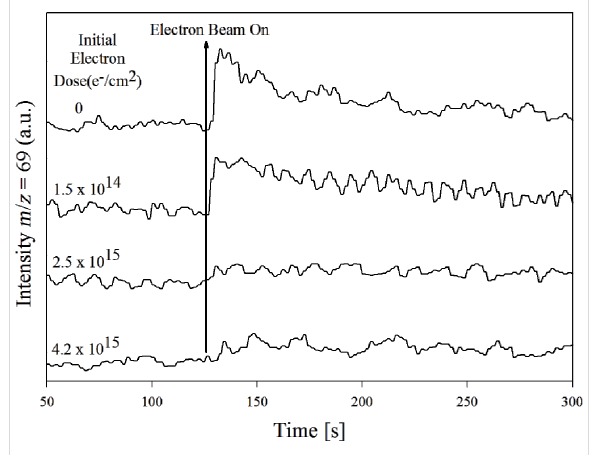
Figure 15: Time-resolved mass spectra of gas phase PF 3 (positive [PF 2 ] + ions produced by 70 eV electron impact are recorded) desorbing from films of Pt(PF 3 ) 4 adsorbed on an Au surface at 180 K when these are irradiated with 500 eV electrons. The time at which the electron beam is turned on is represented with a vertical line. Repro- duced with permission from [23], Copyright (2011) American Chemical Society.